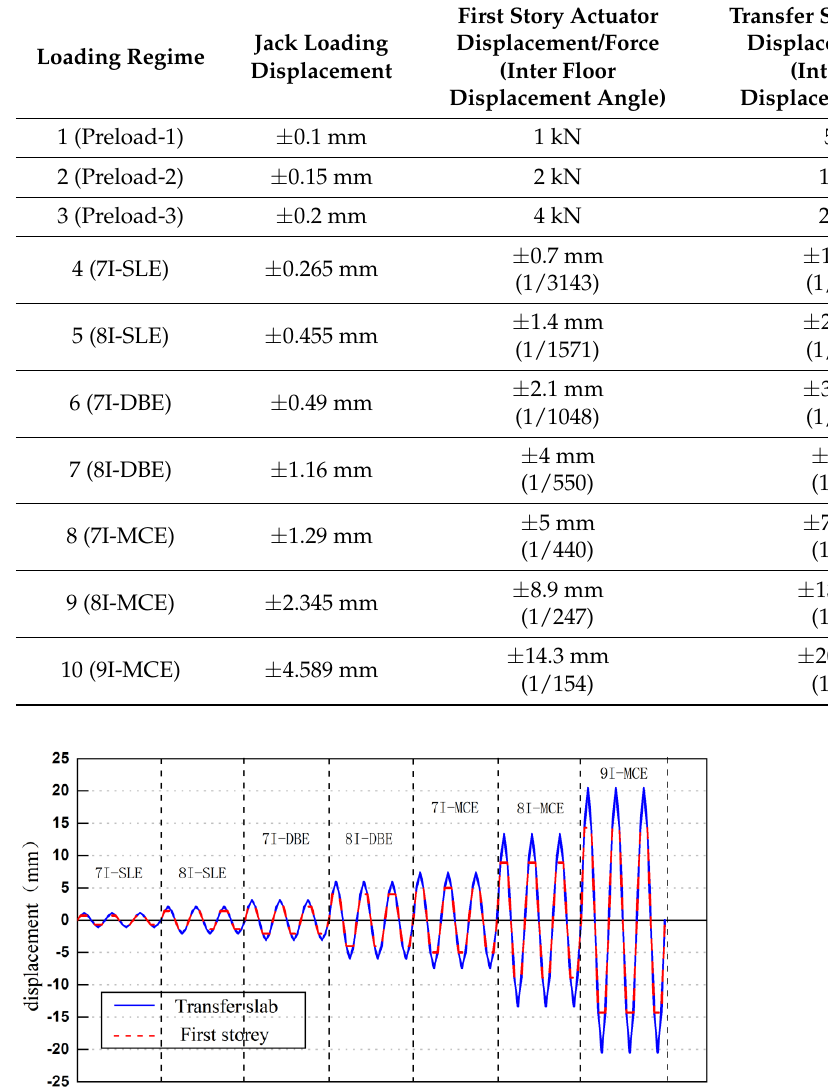
Figure 7. Horizontal l oading